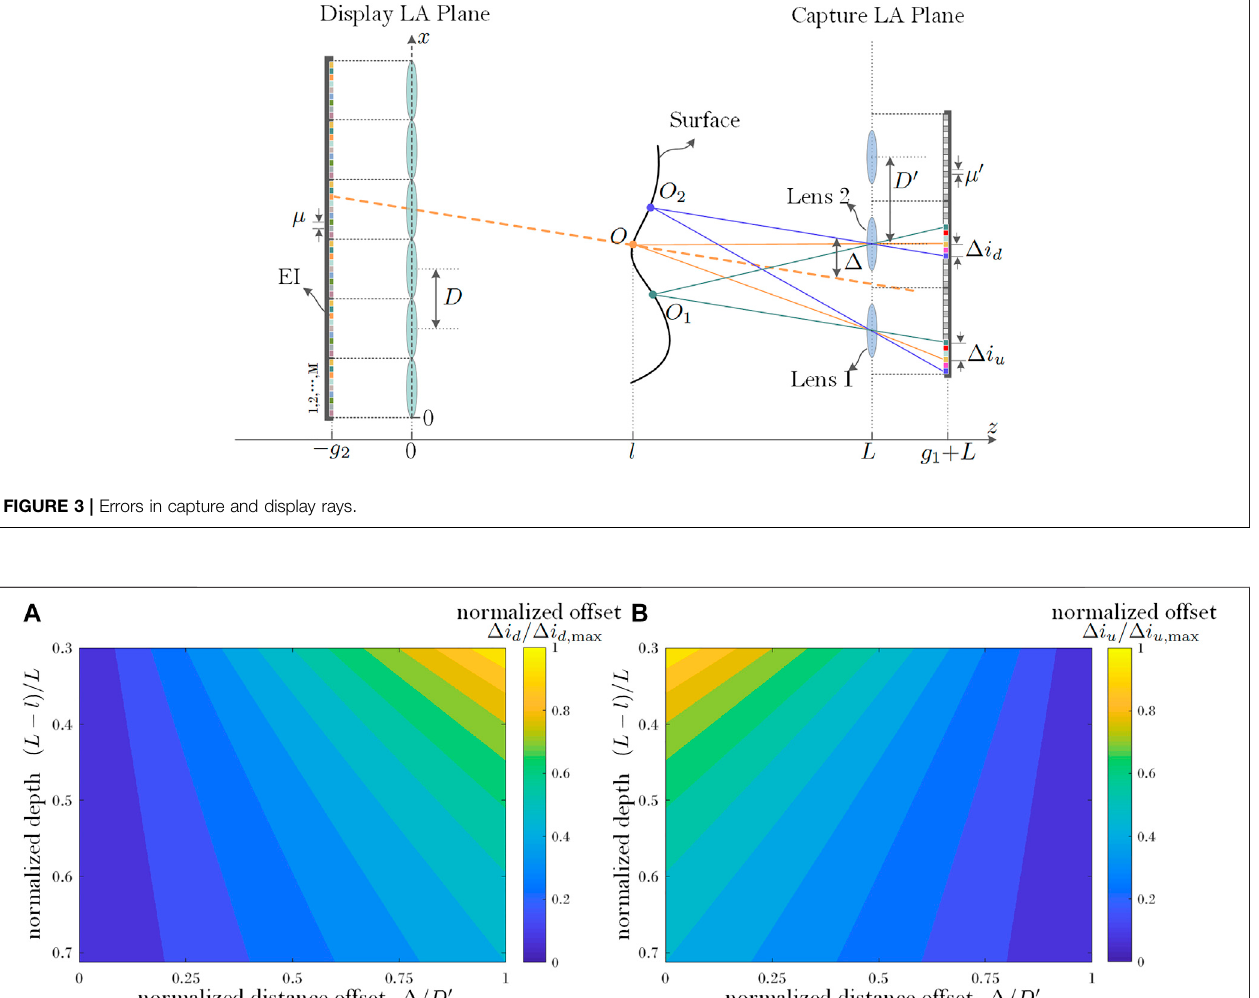
Frontiers in Physics |